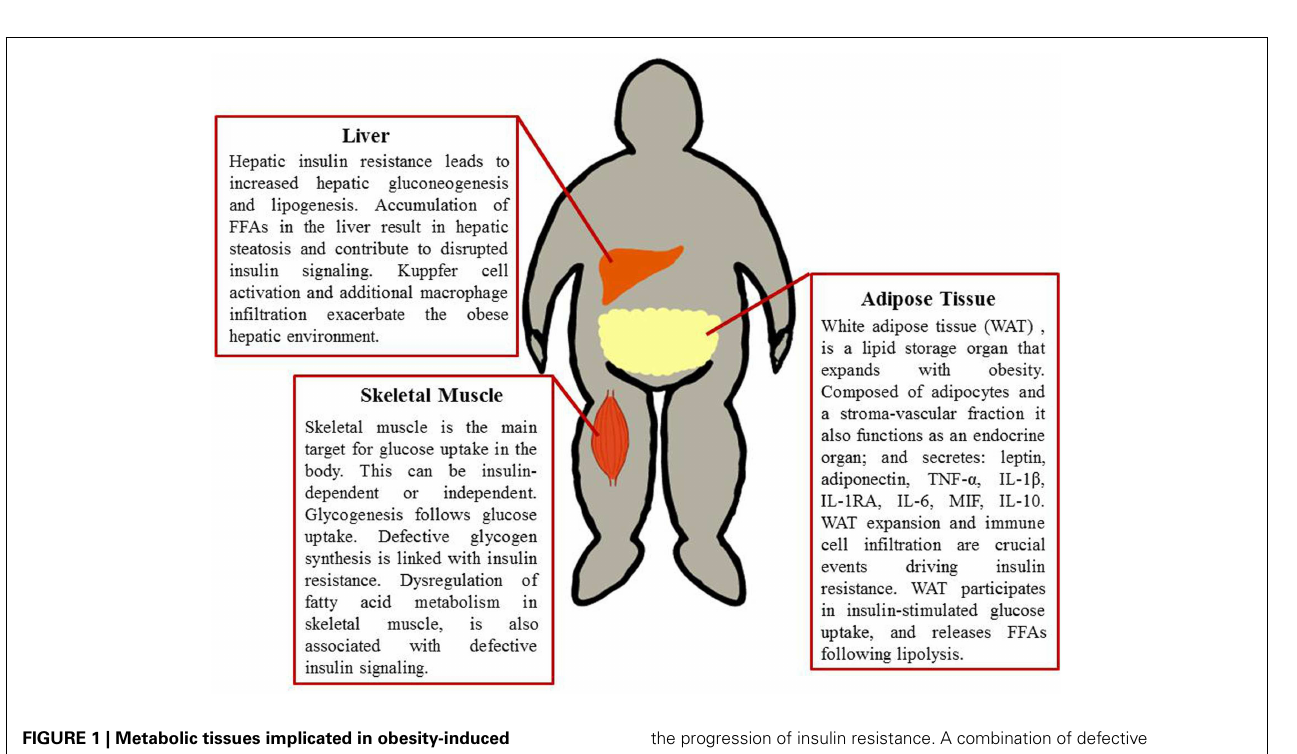
FIGURE 1 | Metabolic tissues implicated in obesity-induced insulin resistance . Adipose tissue, liver, and skeletal muscle are involved in glucose uptake, glucose production, and glucose processing.These tissues therefore are paramount in obesity and